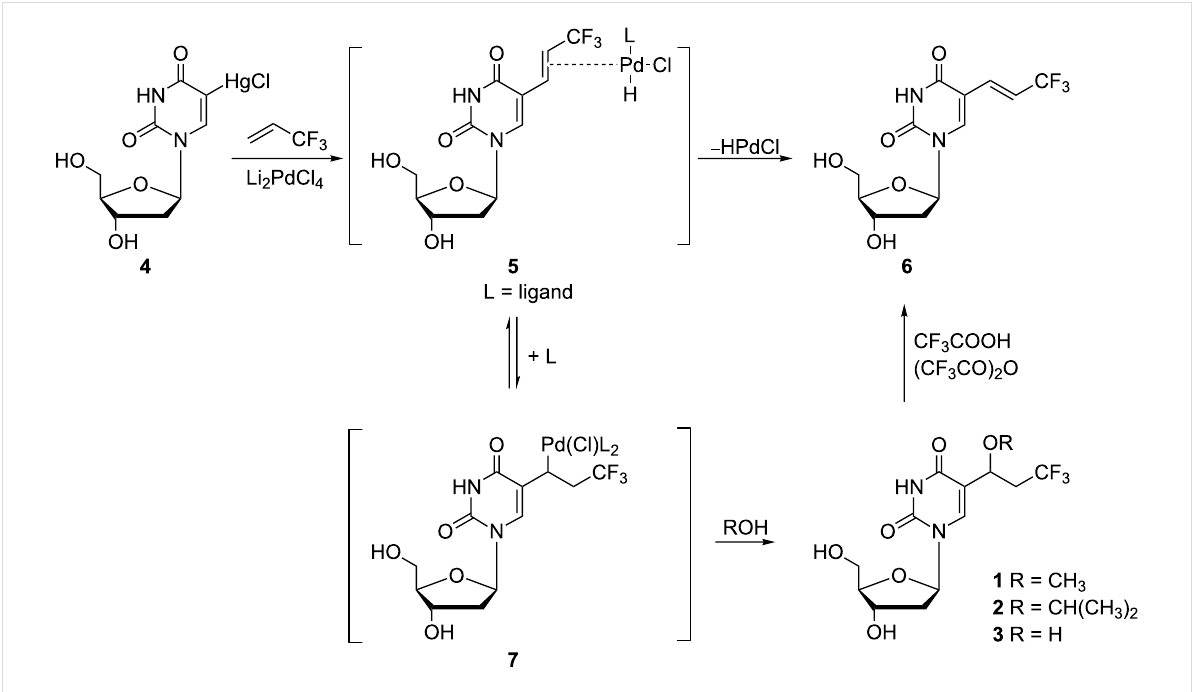
Scheme 1: Synthesis of 5-(3,3,3-trifluoro-1-methoxypropyl)-2'-deoxyuridine ( 1 ) and 5-(3,3,3-trifluoro-1-(2-propyloxy)prop-1-yl)-2'-deoxyuridine ( 2 ).